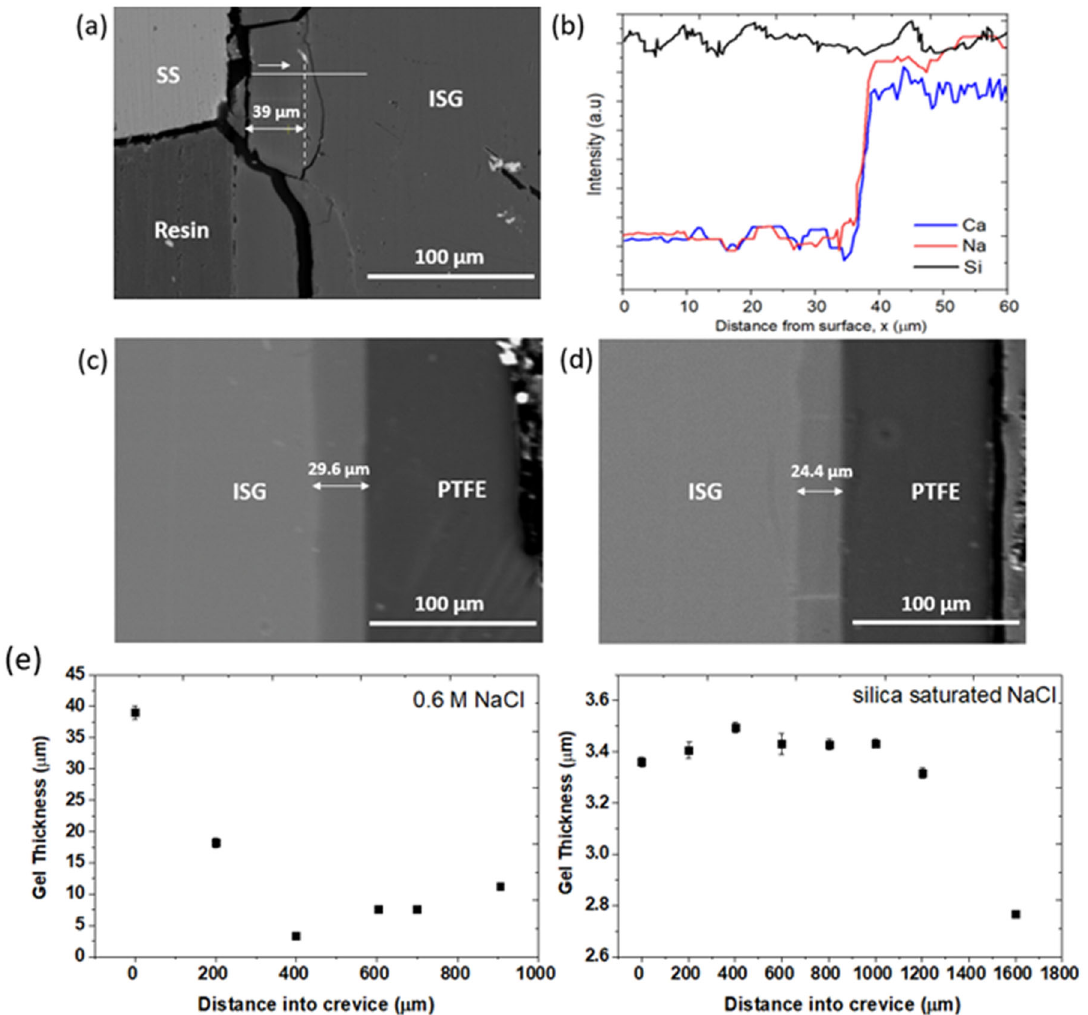
Fig. 5 SEM images of cross-sections of ISG( + SS) and ISG( + PTFE) reacted in 0.6 M NaCl for 1 year. ISG( + SS) cross-section images acquired at ( a ) at the crevice mouth. ( b ) An EDS line scan performed along the white line in ( a ) with the arrow pointing in the direction of the scan ( c ) ISG( + PTFE) cross-section image acquired at the crevice mouth. ( d ) ISG( + PTFE) cross section image acquired at 200 μ m into the crevice mouth. ( e ) The variation of gel layer thickness along the distance into the ISG( + SS) crevice for both 0.6 M NaCl and silica saturated NaCl solutions at the end of t = 365 days of